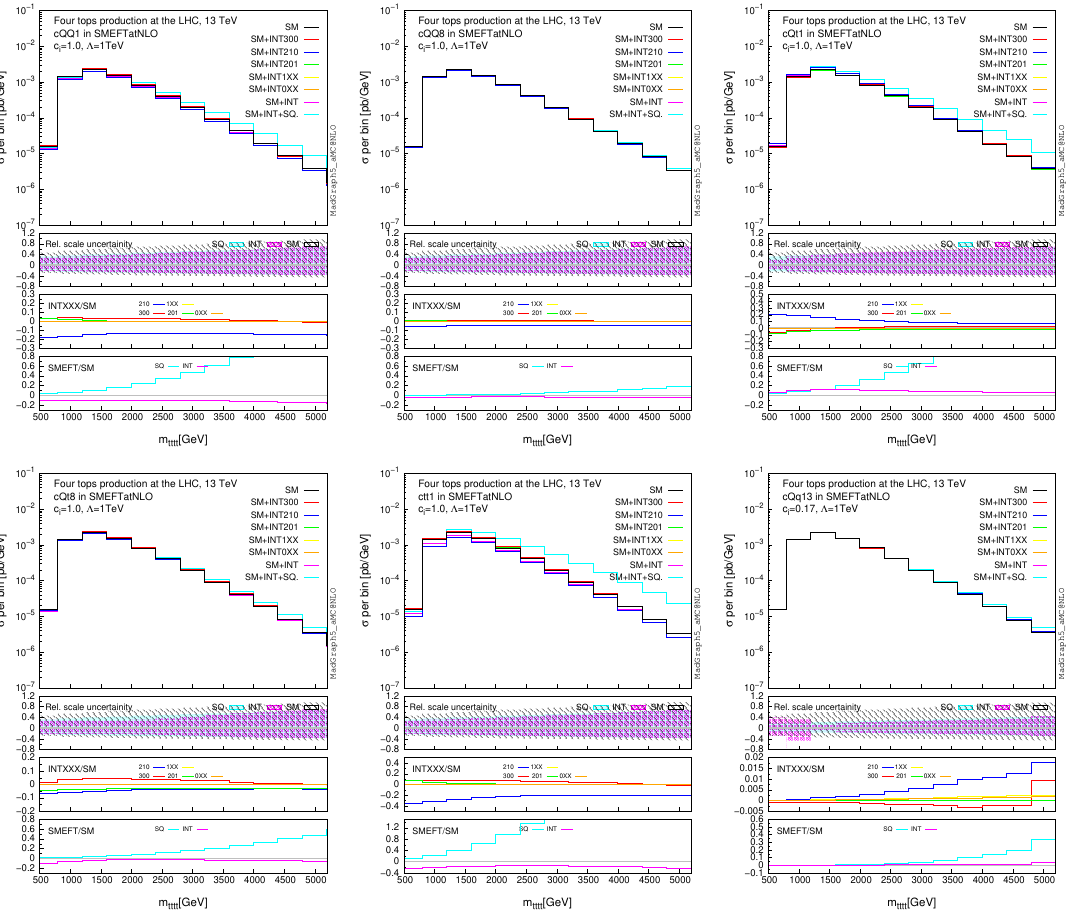
√ Figure 10 . Differential EFT predictions at s = 13 TeV shown in the invariant mass bins of the four top quark system, m tttt , for the set of non-naive four-fermion operators, i.e. all 4-heavy operators and the O 3 , 1 operator. The values of the coefficients are extracted from the global fit study Qq of ref. [29], and Λ is set to 1 TeV. The first inset displays the relative scale uncertainties individually calculated for the SM, the interference, and the squared EFT contributions. The second inset shows the ratio of the interference at each order in α s to the SM prediction. The last inset shows the ratio of the total interference and the total squared contributions to the